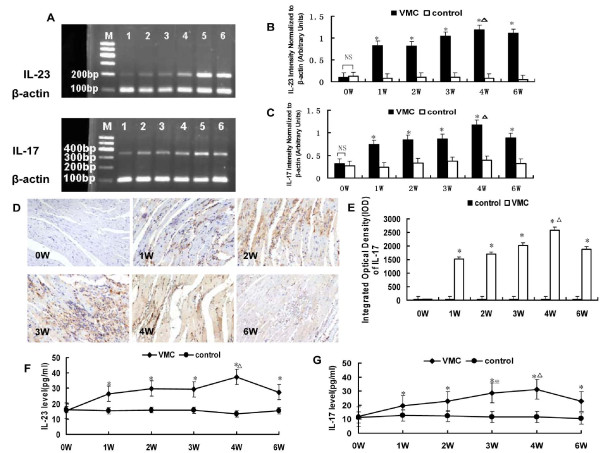
IL-23, IL-17 mRNA and protein expression in the myocardium of mice. A. Strong expression of IL-23, IL-17 occurred from the first week to the sixth week after CVB3 infection inVMC mice. M: Maker; 1: week 0; 2: week 1; 3: week 2; 4: week 3; 5: week 4; 6: week 6. B. Densitometric quantitation of IL-23. IL-23 mRNA expression was elevated in VMC mice from the first week to the sixth week. ΔP < 0.01, versus control group, ΔP < 0.05, versus week 0, 1, and 2 VMC mice. C. Densitometric quantitation of IL-17. IL-17 mRNA expression was elevated in VMC mice from the first week, and the arbitrary units were higher than those of controls. ΔP < 0.01 versus controls, ΔP < 0.05, versus week 0 VMC mice. D. Representative of IL-17 immunohistochemistry images in heart tissue of VMC mice (Dark brown granules, original magnification × 400). E. Morphometric quantitation of IL-17 protein expression. ΔP < 0.01, versus control group, ΔP < 0.05, versus week 0, 1, 2 and 6 VMC mice. F. IL-23 protein levels were steadily increased in the VMC mice, ΔP < 0.05, versus control group, ΔP < 0.05, versus week 0, and 6 VMC mice. G, IL-17 protein levels were steadily increased in the VMC mice from 1 week after i.p, and reached statistical difference comparing with those of controls, ΔP < 0.05. The highest level of IL-17 in VMC occurred on 4th week, ΔP < 0.05, versus week 0, 1 VMC mice. ※P < 0.05, versus week 0, 1 VMC mice.